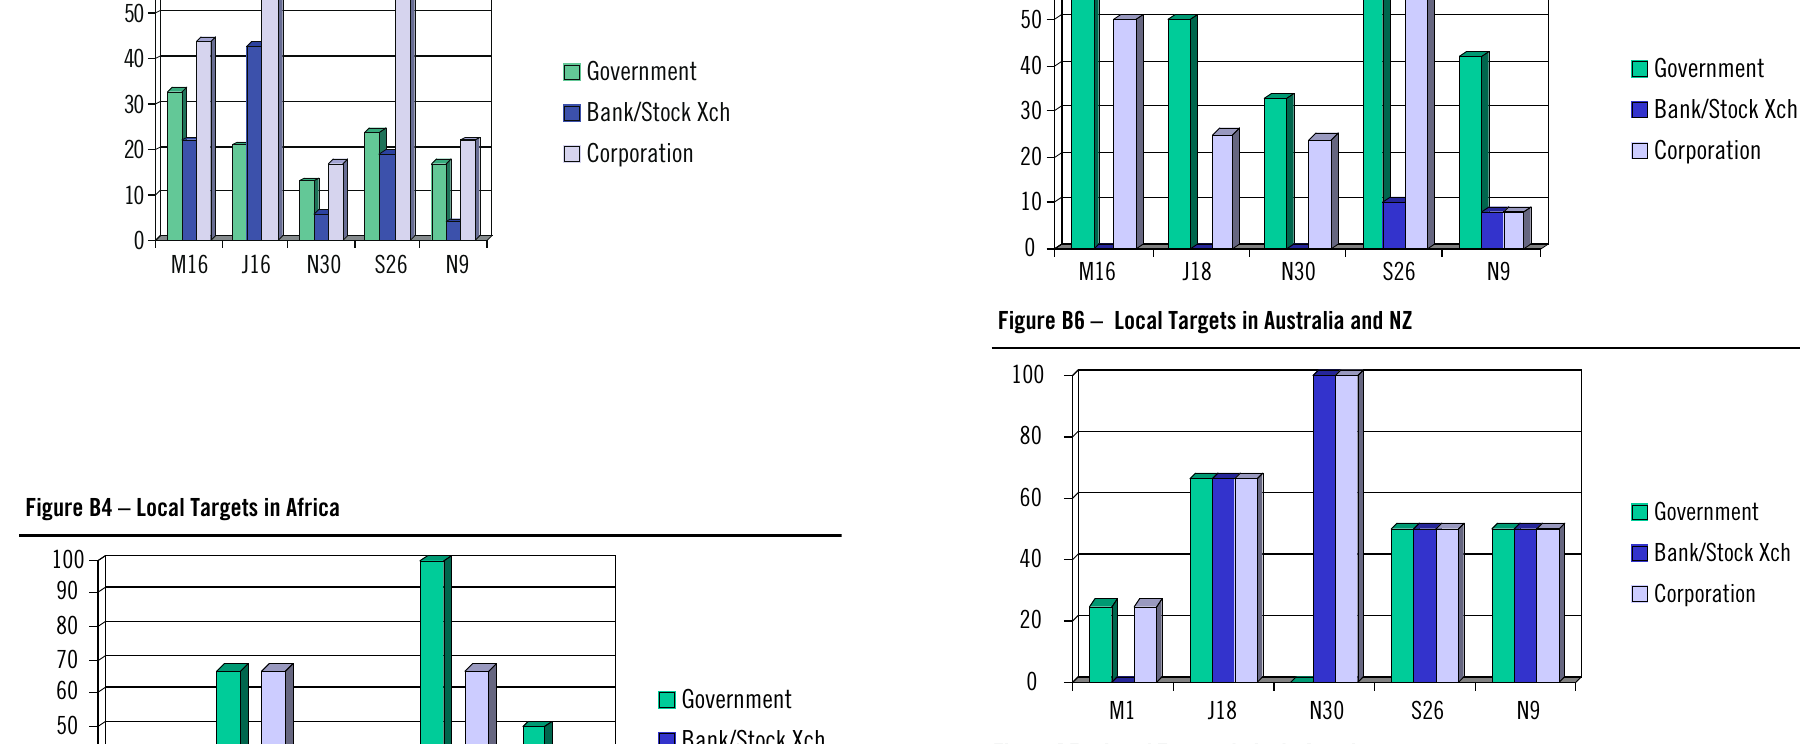
Figure B7 – Local Targets in Latin America